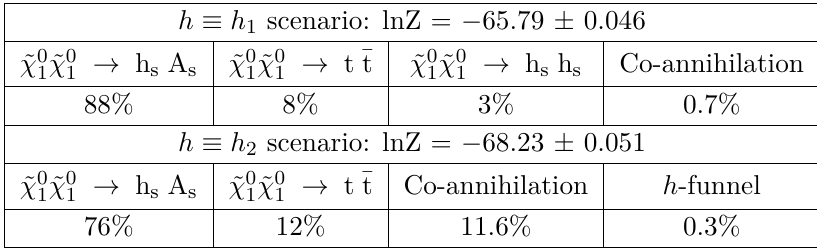
Table 3 . Dominant annihilation channels and their normalized posterior probabilities for h ≡ h 1 and h ≡ h scenarios. In obtaining the values in this table, each sample’s most critical channel for 2 the abundance was identified and sequentially used to classify the samples. The posterior probability densities of the same type of samples were then